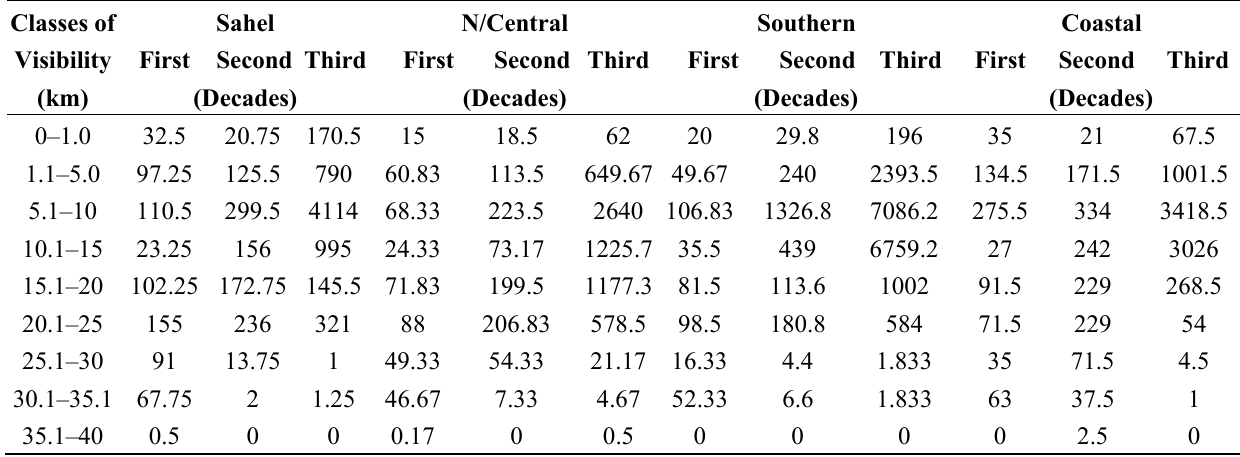
Table 6. Distribution of visibilities in 3 decades at different ranges in